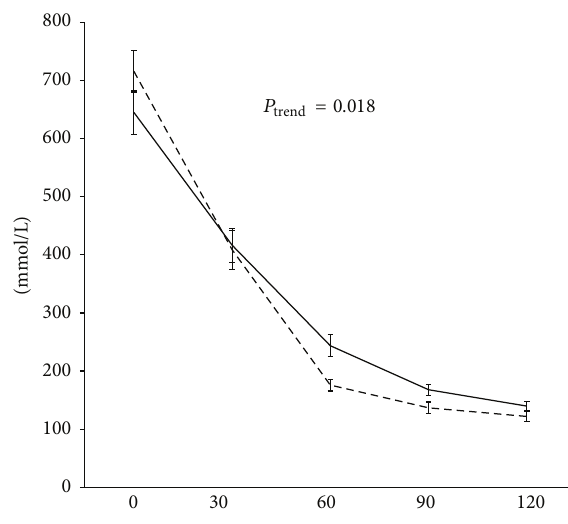
Figure 1: NEFA levels during standard 120-minute 75g oral glucose tolerance test in participants with intrahepatic lipid ≤ 5.5% (dashed line) versus those with intrahepatic lipid > 5.5%, that is, NAFLD (solid line). Data are presented as mean ± SE. 𝑃 derived from linear regression modelling with IHL treated as a continuous outcome variable and the exposure being the area under the NEFA curve, adjusted for age, gender, alcohol consumption, and visceral fat